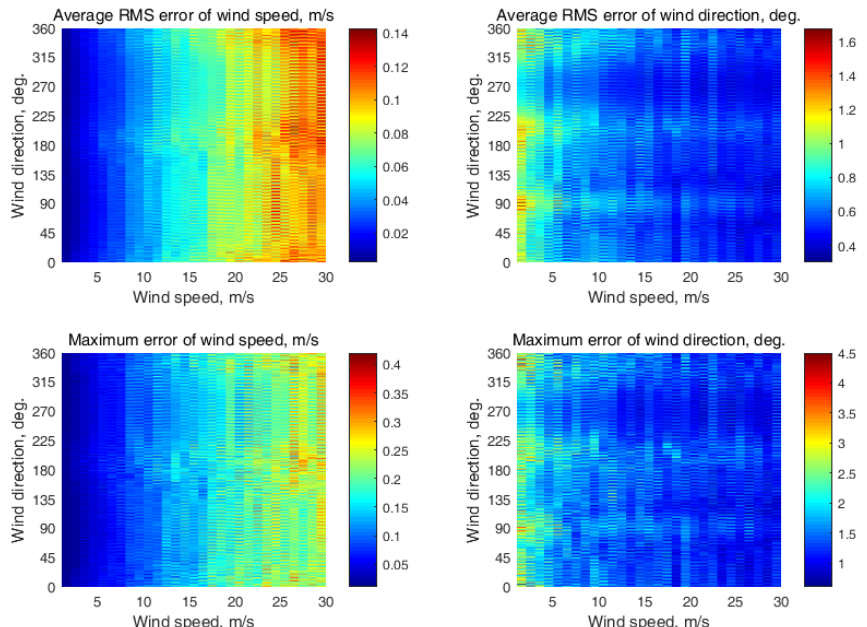
Figure A22. Semicircular wind retrieval results at the (40°, 45°, 50°, 55°) incidence angle combination.